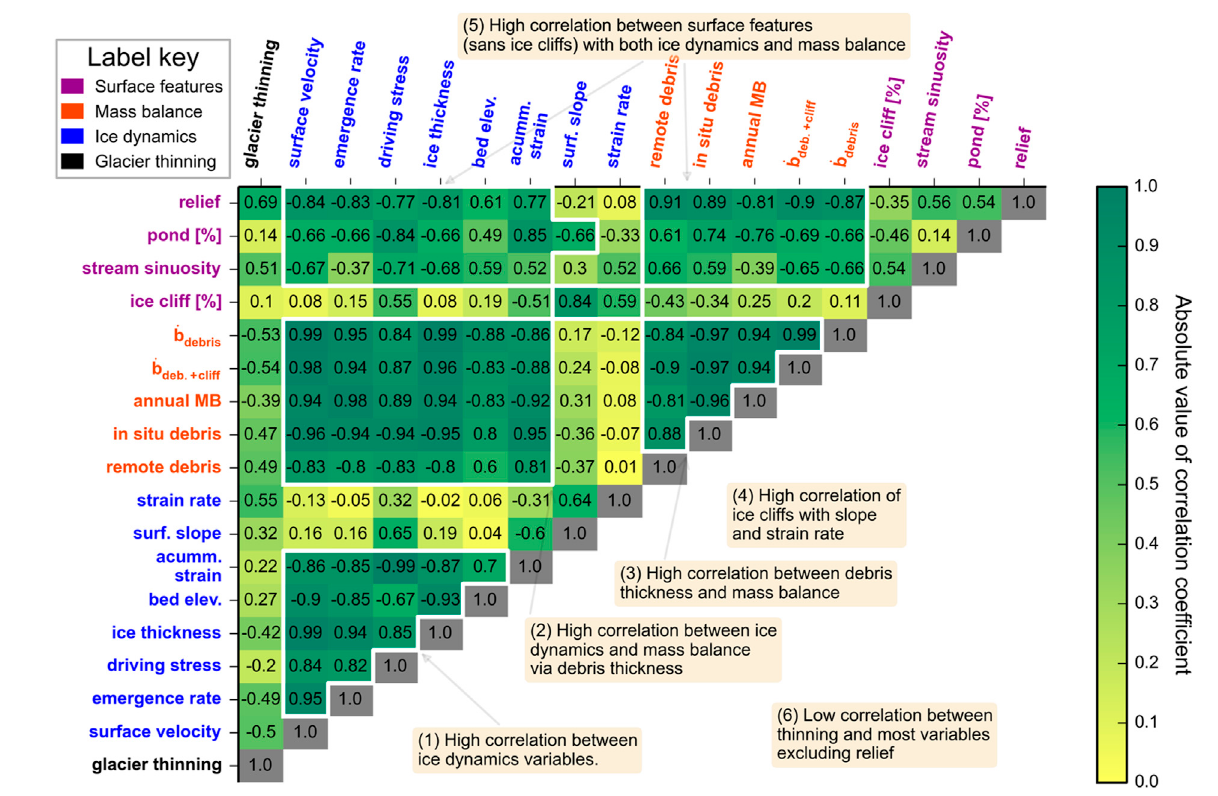
Figure 8 is the cross-correlation matrix for glacier change over multiple decades. See Figure 3 for the signs of individual terms in Figure 8 . Glacier surface elevation change (1957 – 2016) and its